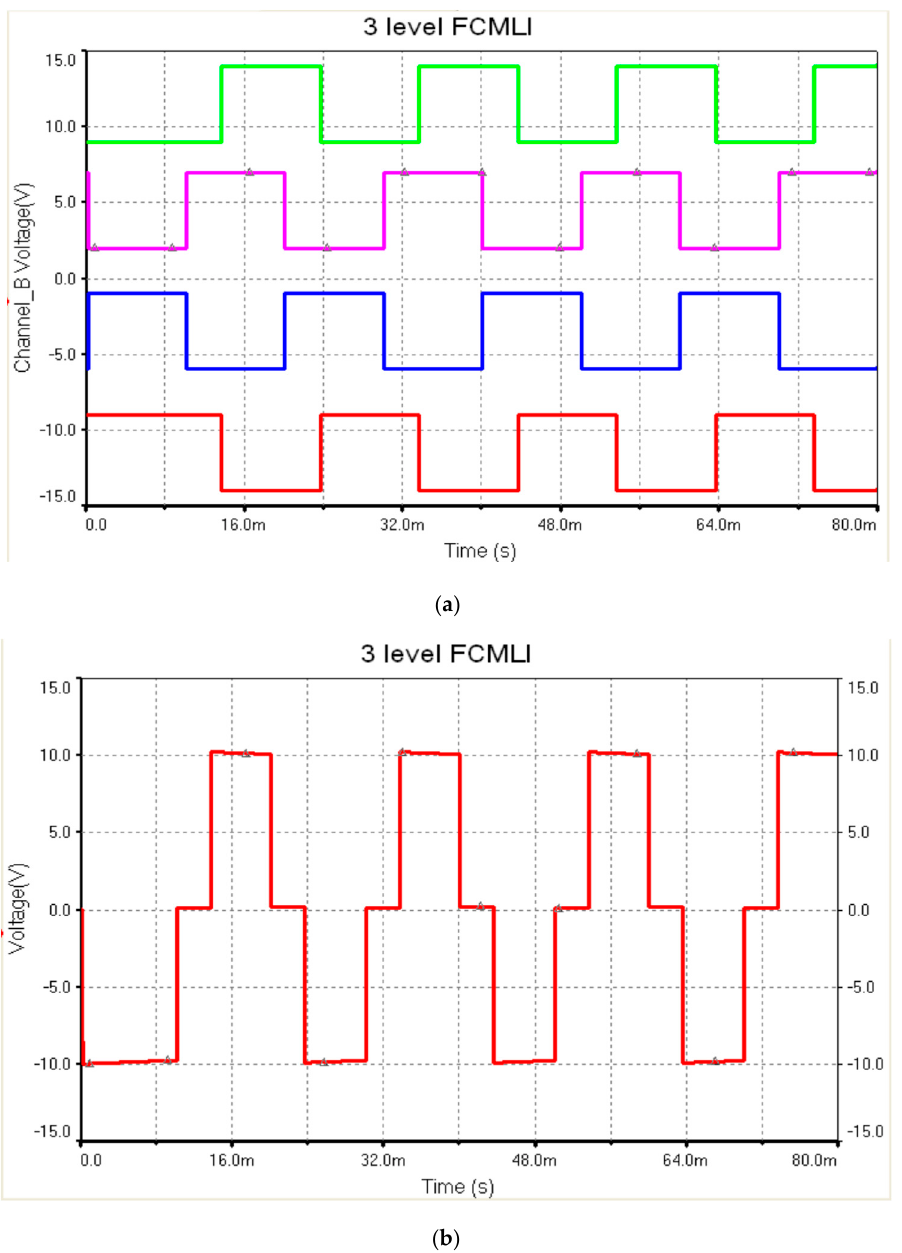
Figure 13. ( a ) Gate pules of 3-level FC-MLI; ( b ) phase output voltage waveforms of a 3-level FC-MLI using MULTISIM.